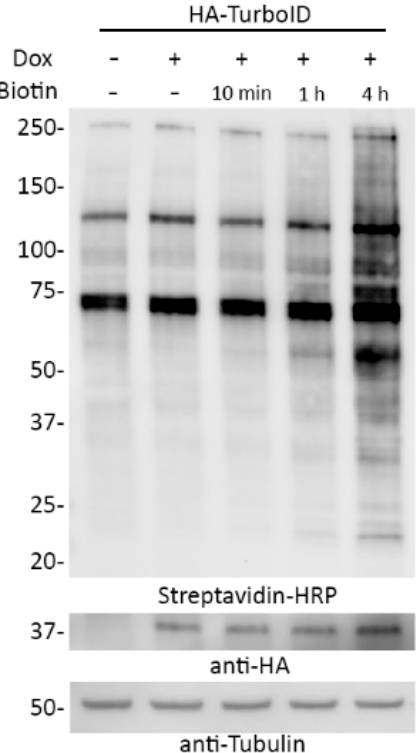
Figure 9. Inducible biotinylation can be achieved by combining dox-inducible TurboID expression with growth in biotin-depleted media. A549 cells stably expressing dox inducible HA-tagged TurboID were incubated with doxycycline and DMEM with 10% dialyzed serum for 18 h prior to the addition of biotin. The cells were then incubated with biotin for either 10 min, 1 h, or 4 h. Streptavidin-HRP was used to visualize biotinylation levels. Anti-HA was used to observe fusion protein levels. Anti-tubulin was used as a protein loading